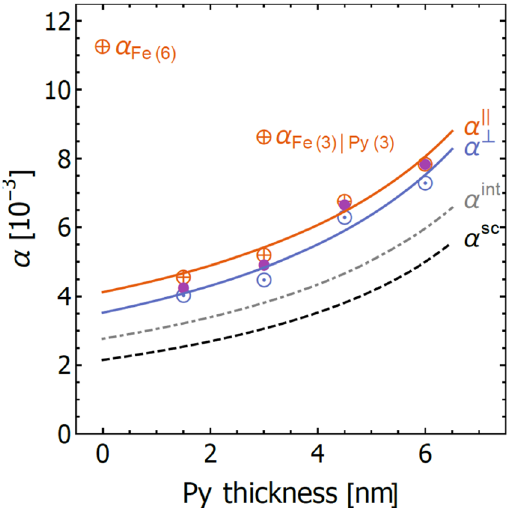
Figure 4. Gilbert damping as function of Py thickness ( d Py = 0, 1.5, 3.0, 4.5, and 6.0 nm) in magnetic bilayer − d d Py Fe 6 ( ) ( ) . Data is shown for the in-plane all frequencies ( ), in-plane high frequencies 50–67 GHz Py Py ( ), and perpendicular-to-plane ( ) FMR configurations. The solid lines, α ⊥ and α , are fits to the data using eq. (7). The two outlier points show very large enhancement in damping for samples where Fe was deposited before Py. α int is the fit of the perpendicular-to-plane damping using eq. (7), with the contribution on due to spin pumping in Ta subtracted off. The fitting parameters are α α α = − × 10 Feint 3